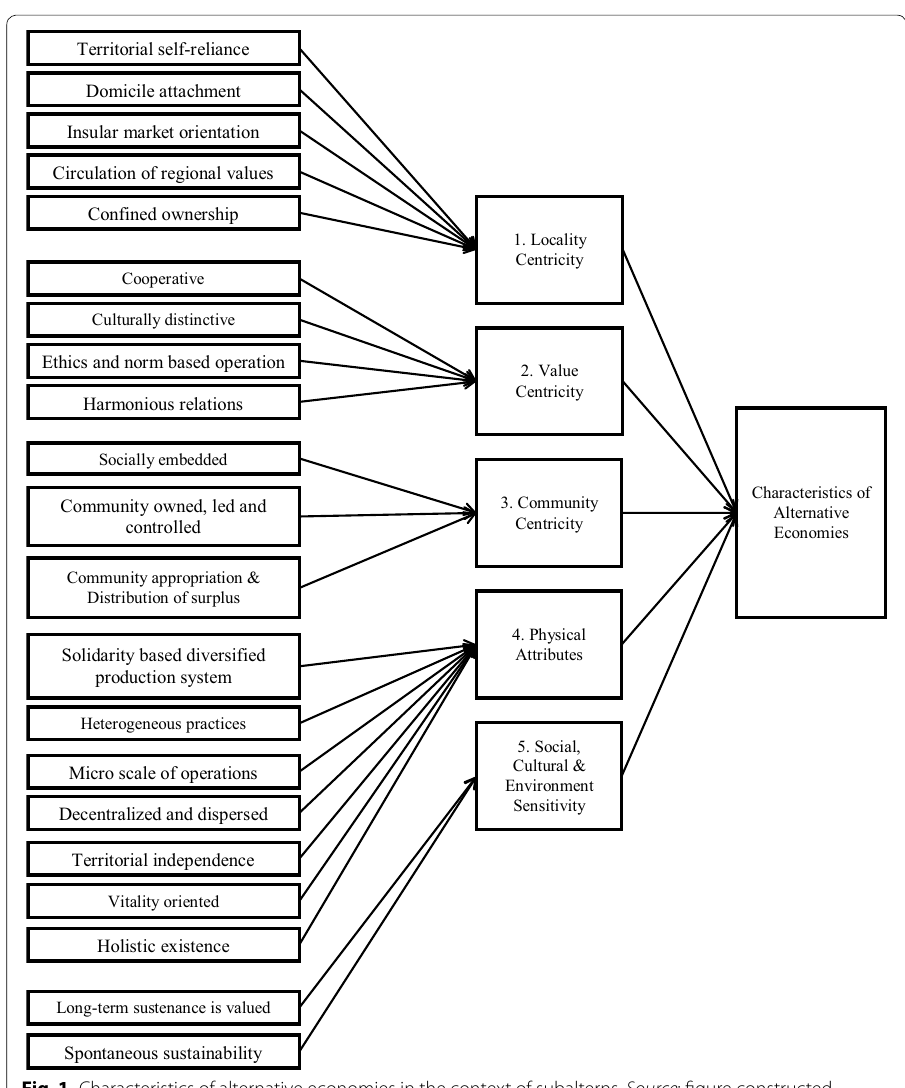
Fig. 1 Characteristics of alternative economies in the context of subalterns. Source : figure constructed by authors with a special emphasis on subalterns from a list of the characteristics of alternative economy provided by Campana et al. (2017) and also inspired by The Community Economies Framework (Gibson-Graham 2006, p.